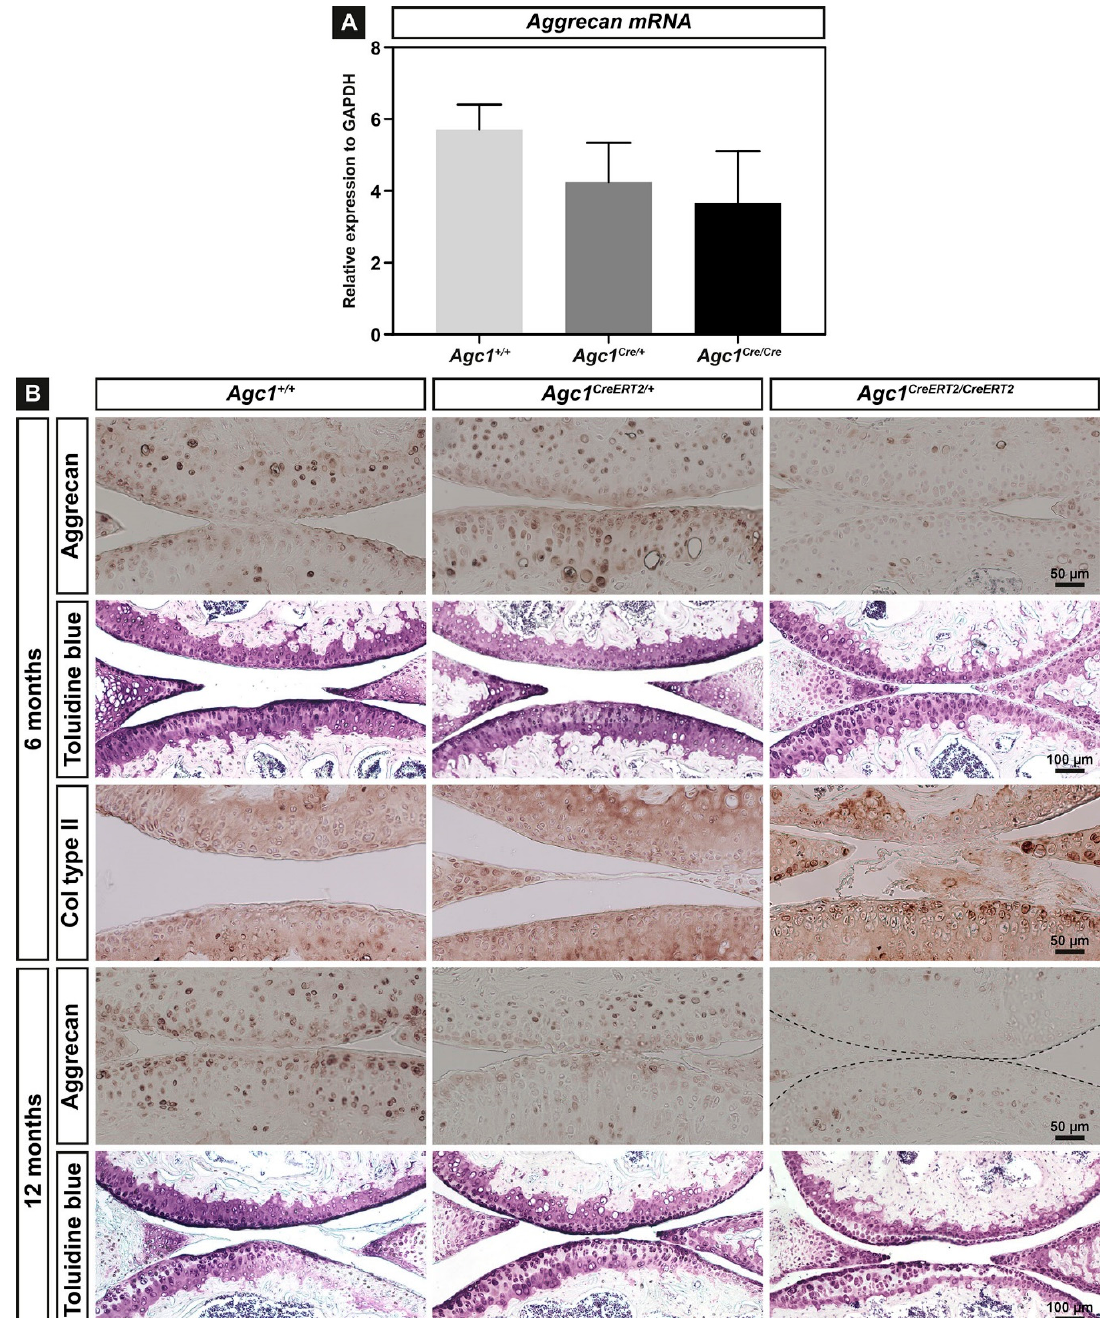
Figure 2. Expression of aggrecan in cartilage of mice carrying the CreER T2 transgene. ( A ) relative gene expression of Agc1 in newborn rib cartilage primary chondrocytes of Agc1 +/+ , Agc1 CreERT2/+ and Agc1 CreERT2/CreERT2 , mice. The mean values ± SD from three independent animals of each genotype are shown; ( B ) sagittal sections of the knee joint were stained with antibodies against aggrecan, collagen type II, and with Toluidine blue. n = 5 mice per genotype.